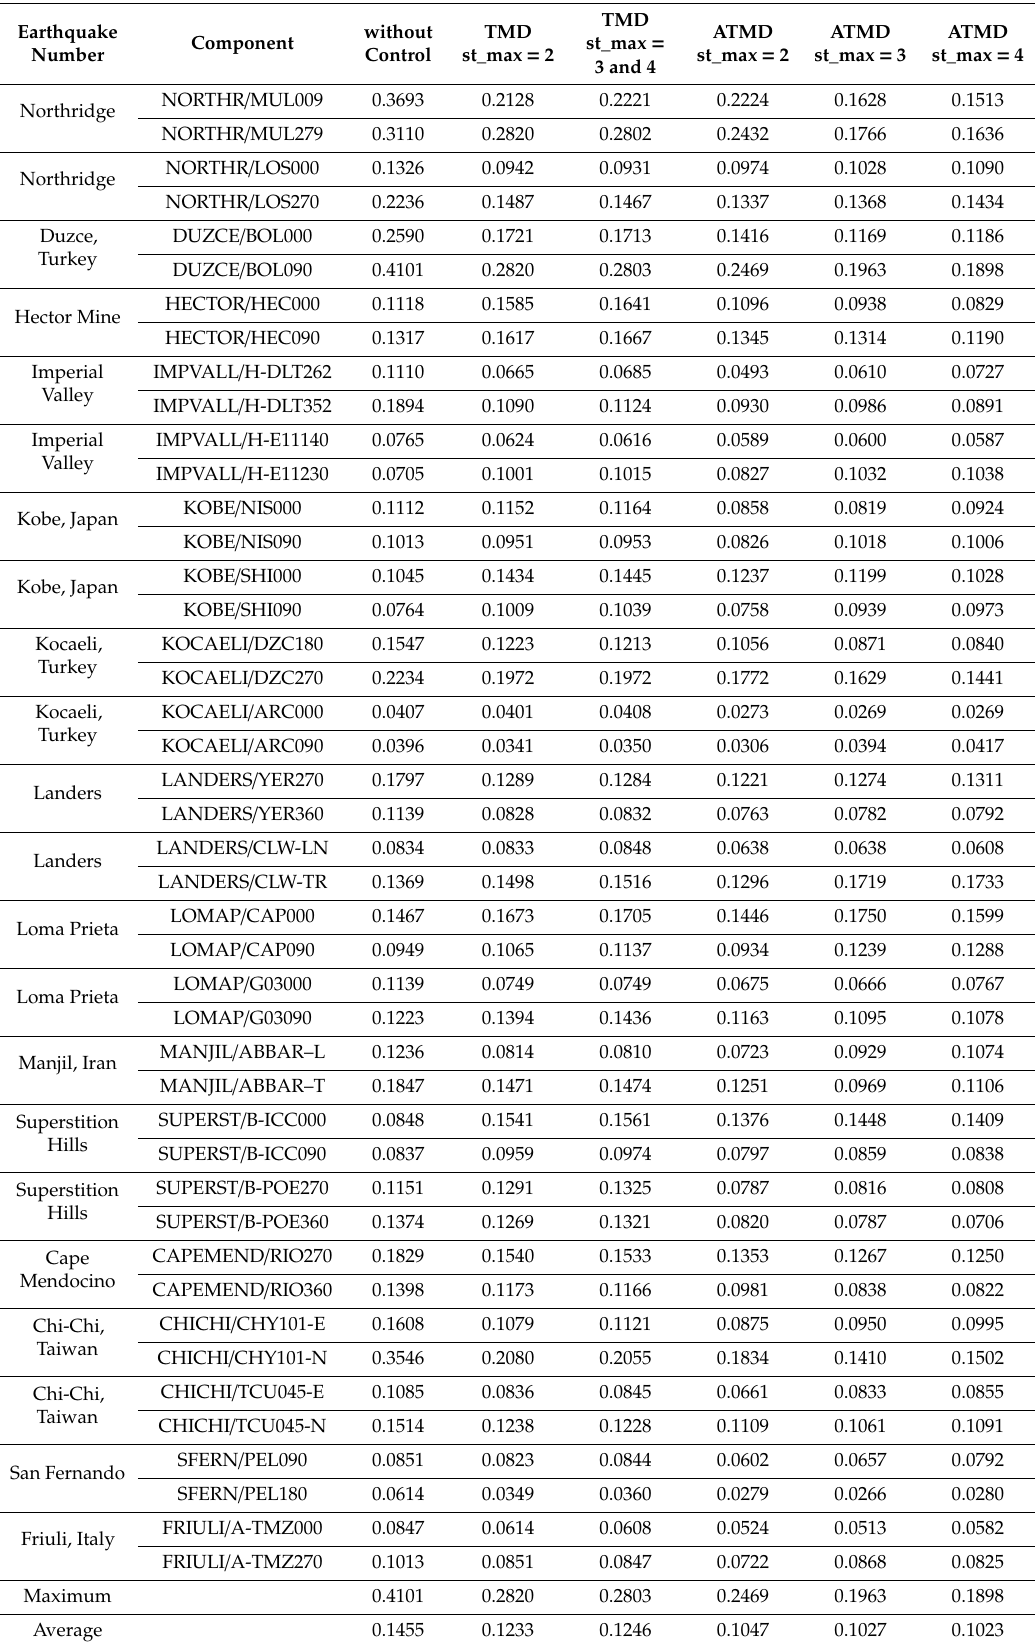
Table 4. Maximum top story displacement for FEMA P-695 far-field ground